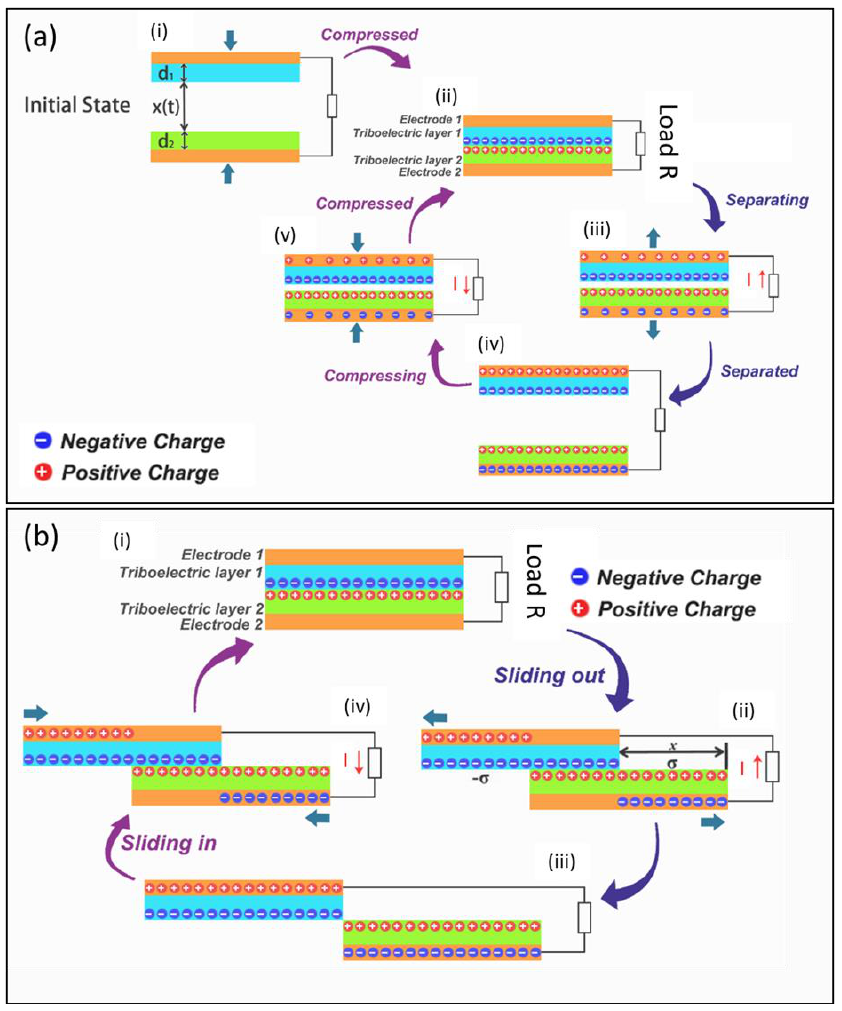
Figure 2. ( a ) Schematic of one complete charge generation cycle of a vertical contact-mode Triboelectric Nanogenerator (TENG), and ( b ) schematic for a standard parallel sliding-mode triboelectric nanogenerator.